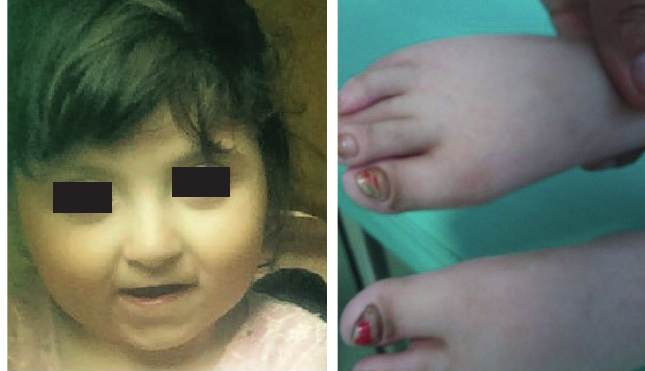
Fig 1: Moon face,small open mouth